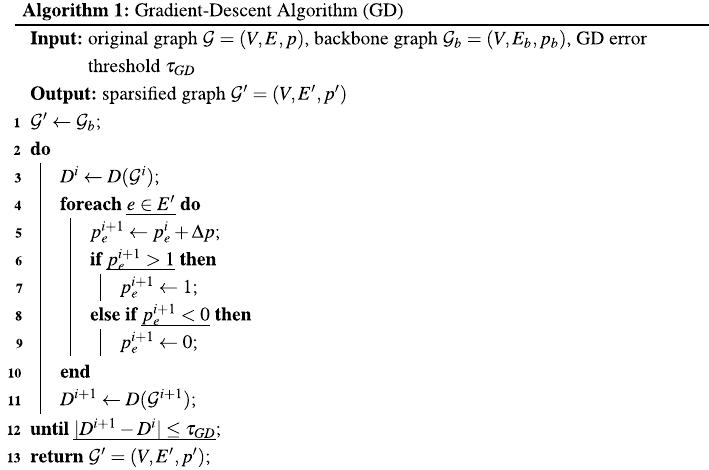
Algorithm 1 only modifies the probability of the edges of the input backbone graph G b . Therefore, the output sparsified graph modification of the Gradient-Descent (GD) algorithm but also on Parchas et al. (2018) proposed Expectation-Maximization (EM) algorithm that both G rewires b and modifies edge